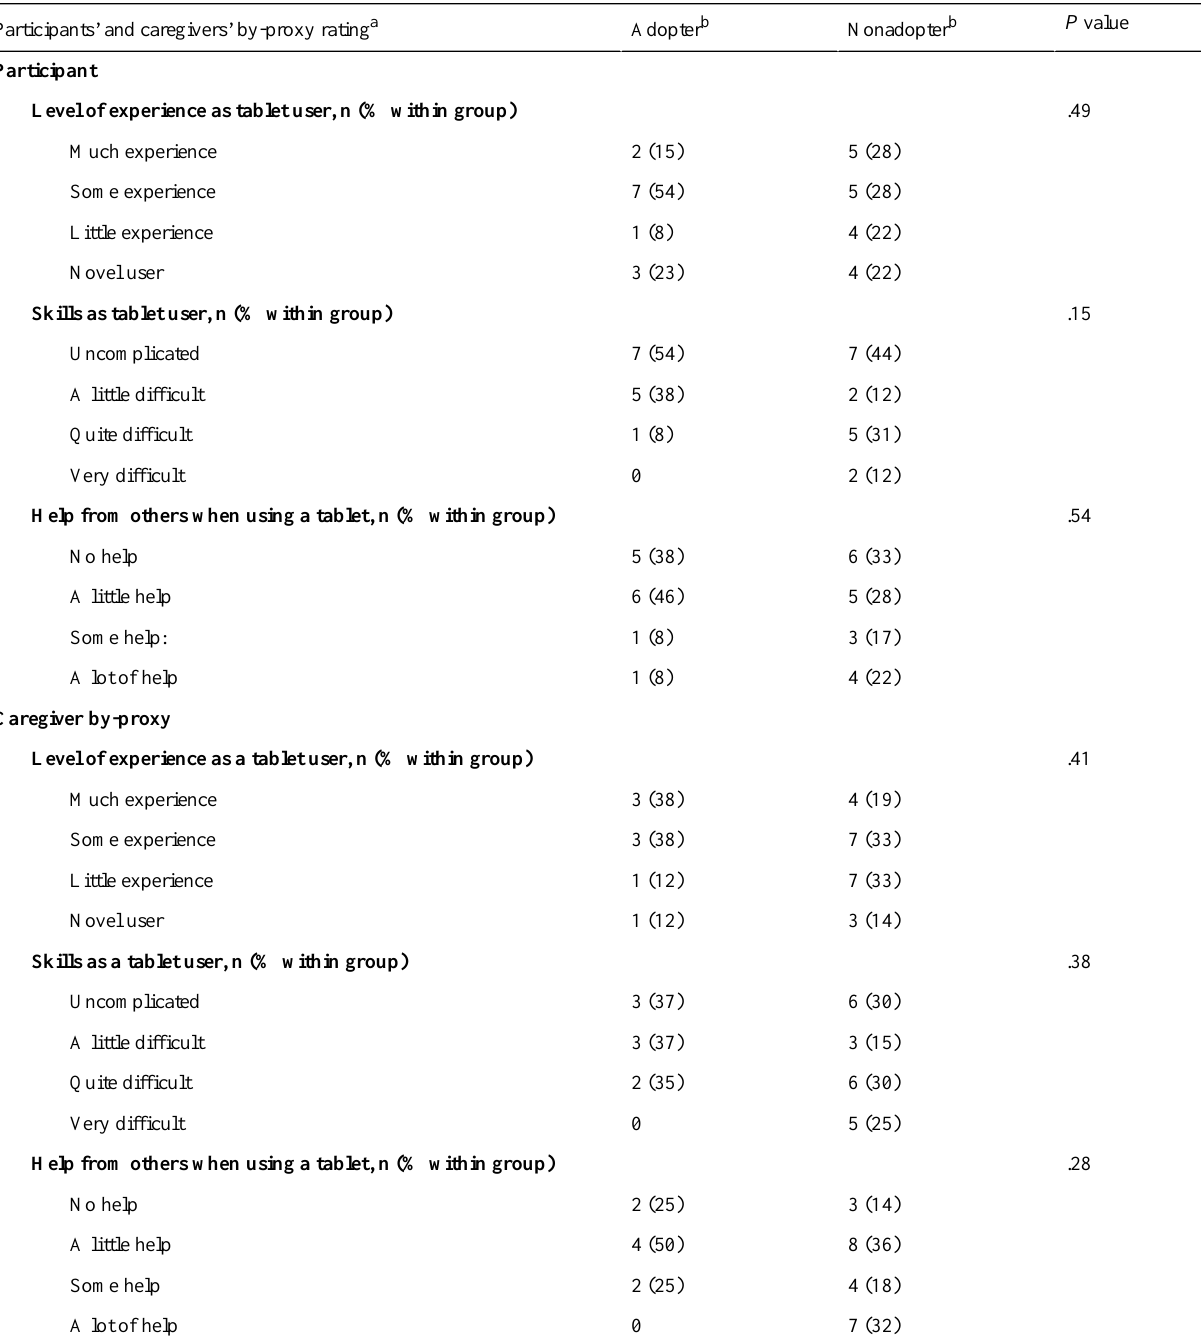
Table 5. Data from survey: participant’s and caregiver’s rating of the participant’s level of experience, skills, and need for help when using a